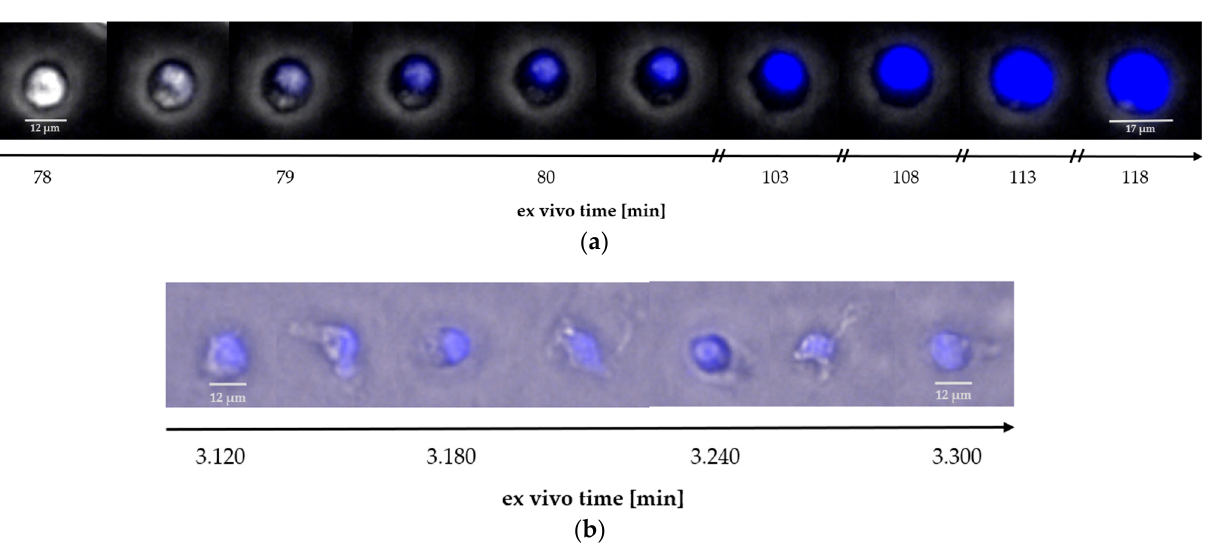
Figure 5. Examples of DAPI-stained PMNs from di ff erent isolation methods. ( a ) DAPI staining in a non-migrating PMN isolated by DGS. The fl uorescence signal increased strongly in intensity within 30 min. The cell diameter was initially 12 µm (ex vivo time: 78 min) and increased to 17 µm (118 min).( b ) DAPI staining in a vital PMN after isolation without centrifugation using gelafundin as sedimentation enhancer. The intensity of the fl uorescence signal in the migrating PMN did not in- crease signi fi cantly over time. The diameter of the PMN remained constant over time at 12 µm.